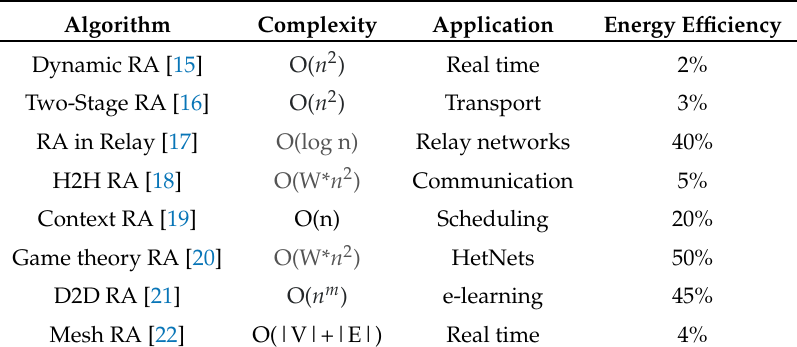
Table 1. Related work